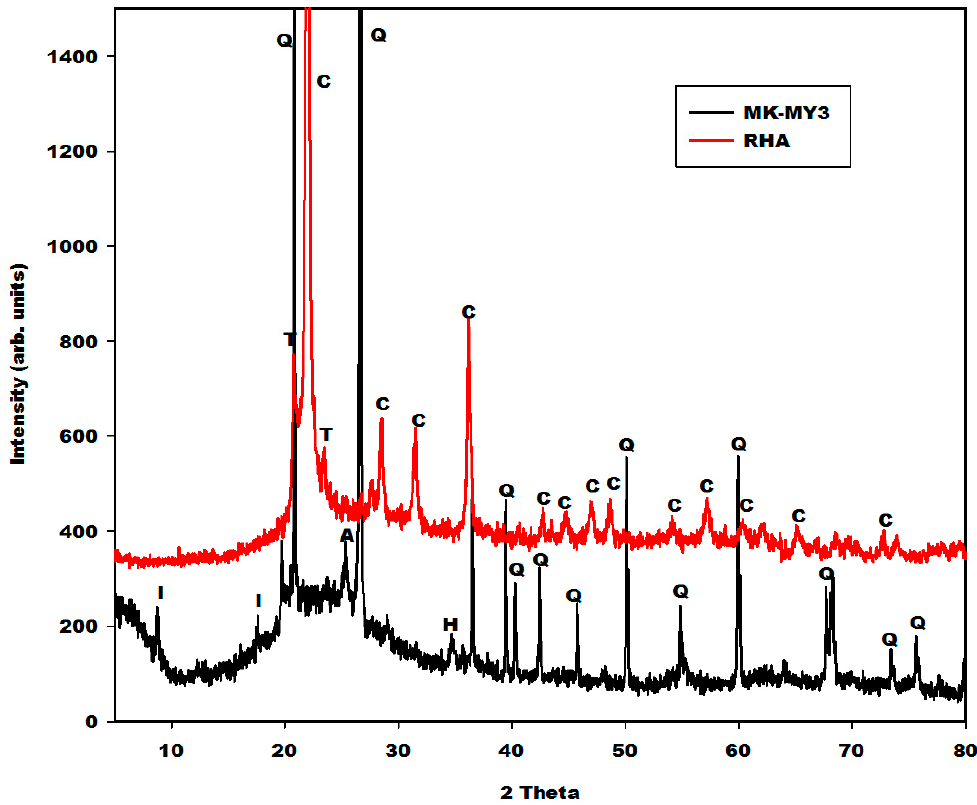
Figure 2. X-ray patterns of rice husk ash (RHA) and metakaolin (MK-MY3). I, Q, A, H and C, T referred to the peaks of illite, quartz, anatase, hematite, cristobalite and tridymite, respectively.